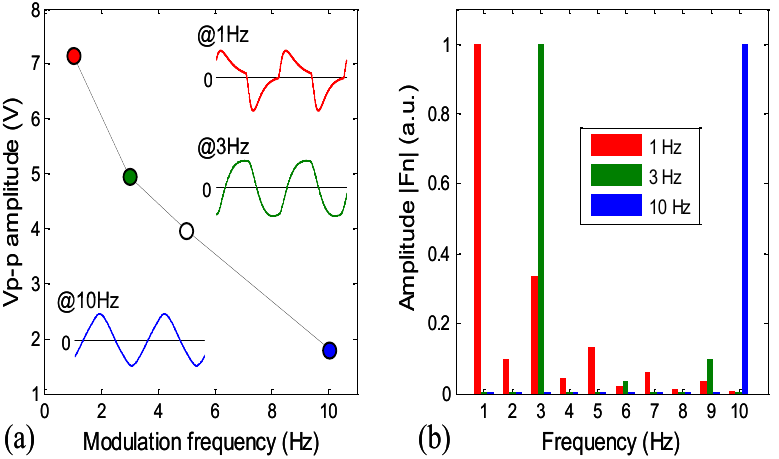
Figure 4. ( a ) Modulation depth and waveforms at different frequencies; ( b ) Spectra of different waveforms with a 1 s sampling